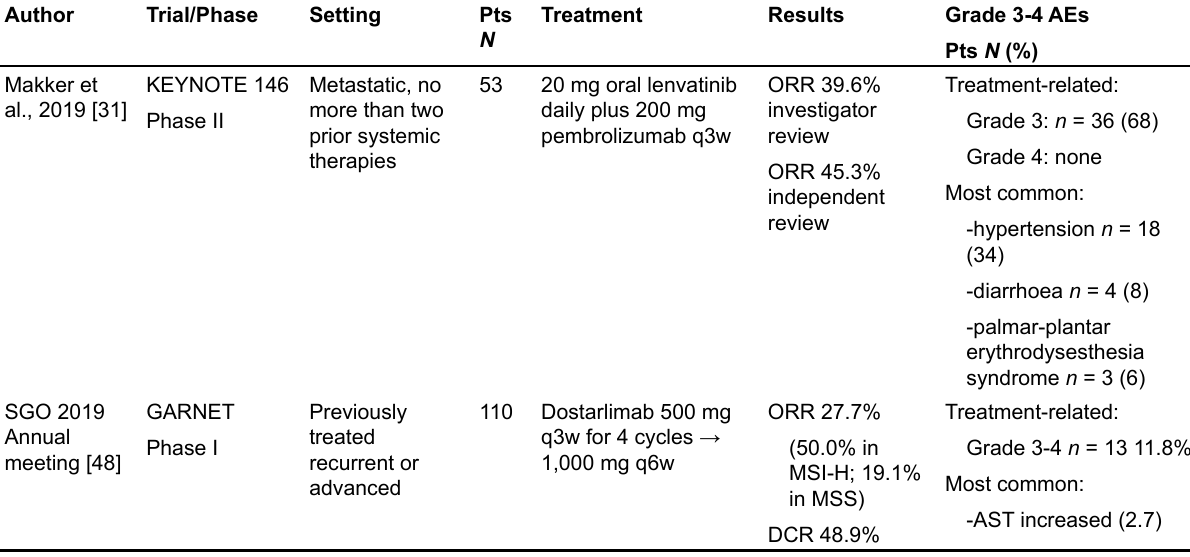
Table 2. Clinical trials in EC ( continued